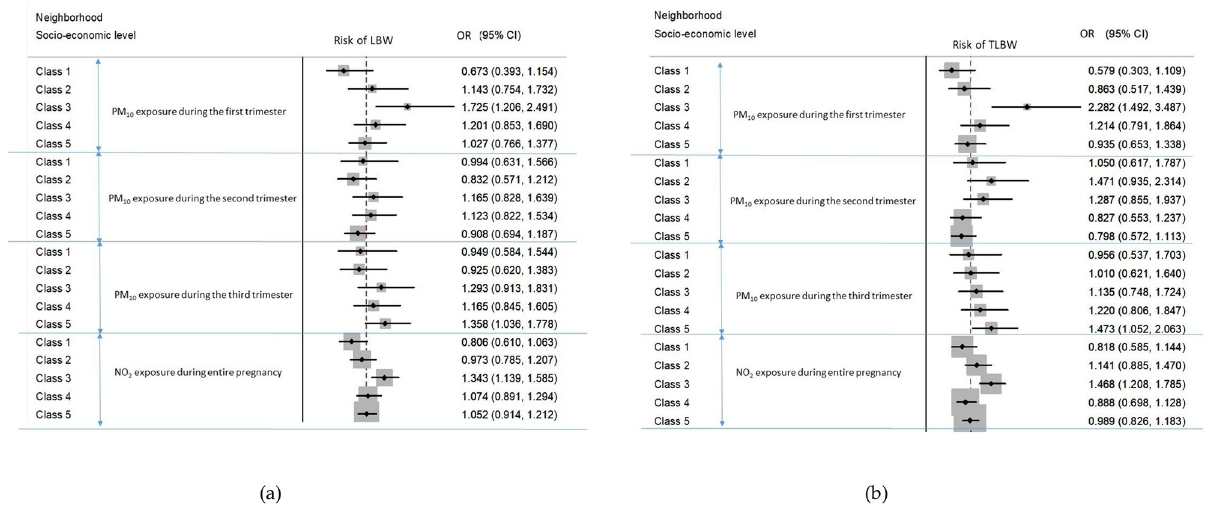
Fig 1. Effect of air pollution according neighborhood socio-economic category: (a) risk of LBW; (b) risk of TLBW. These results were presented because the interaction term between air pollution and socioeconomic categories were statistically significant.